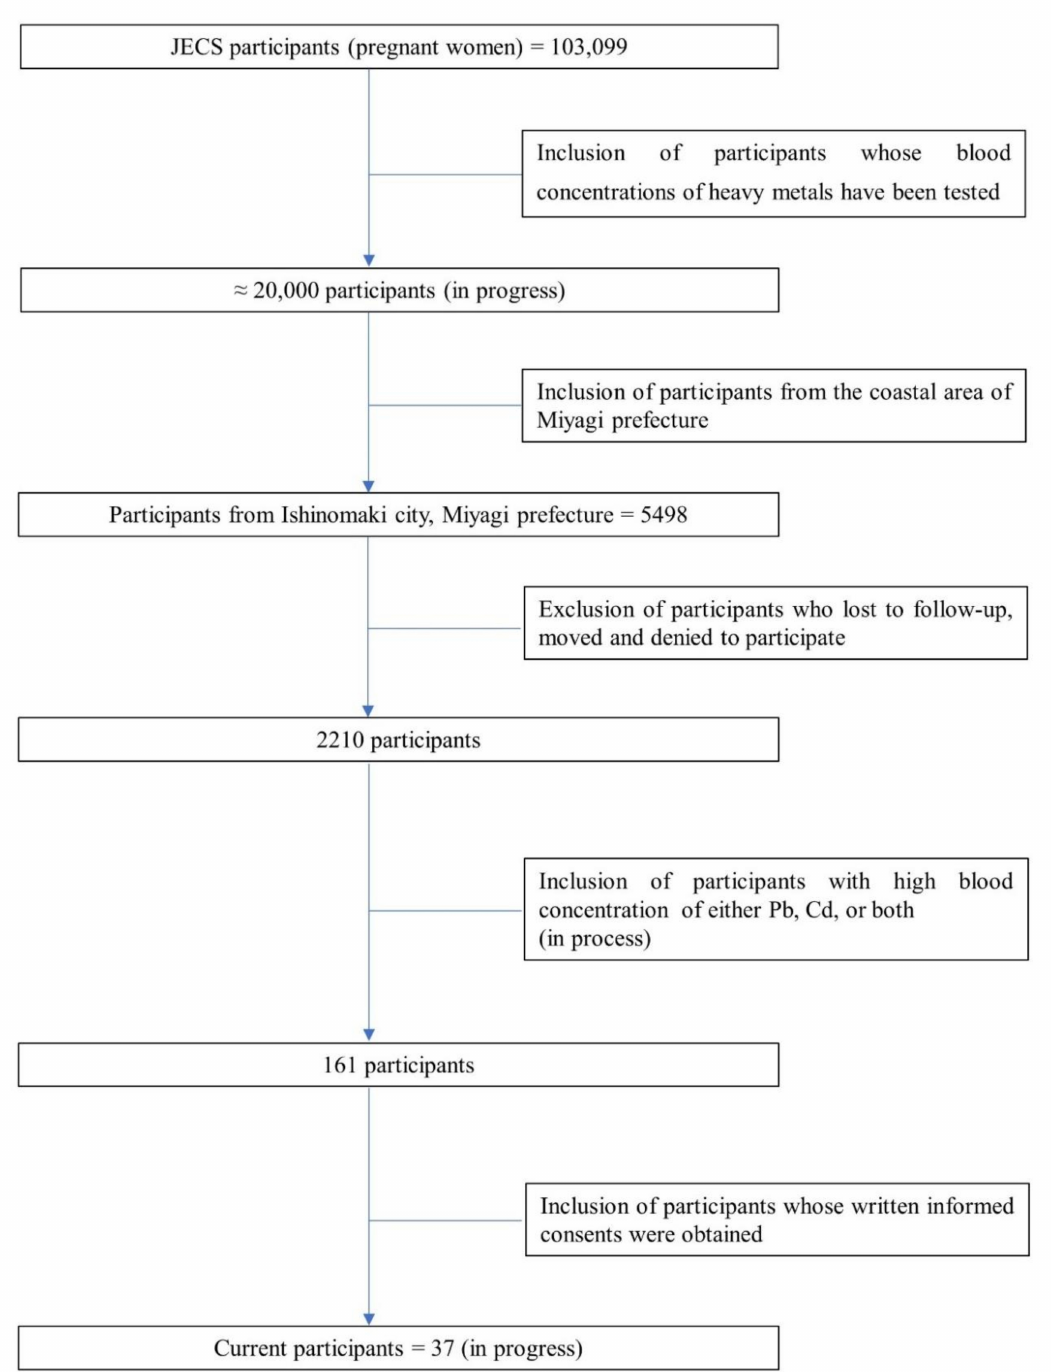
Figure 1. Process of enrollment to this study. The participants were recruited from the coastal area of Miyagi prefecture,